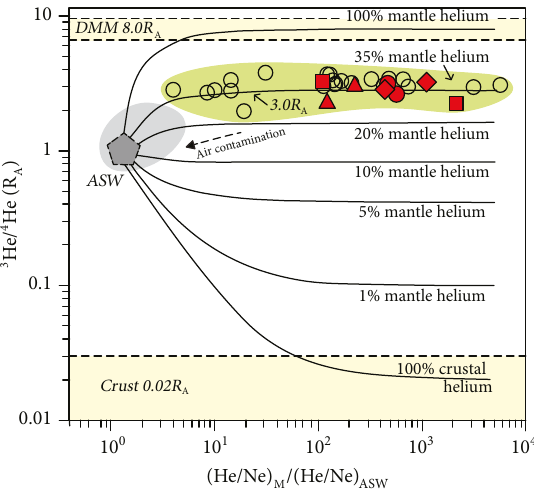
Figure 7: 3 He/ 4 He ( R A ) versus (He/Ne) M /(He/Ne) ASW for cold spring gases in WMVF. The calculated binary mixing curves between the air-saturated water (ASW) and crust-mantle mixtures with variable proportions of mantle helium (e.g., 100%, 35%, 20%, 10%, 5%, 1%, and 0%) are shown. Reference values for end members are as follows: ASW: 3 He/ 4 He = 0 987 R A [55], crust: 3 He/ 4 He = 0 02